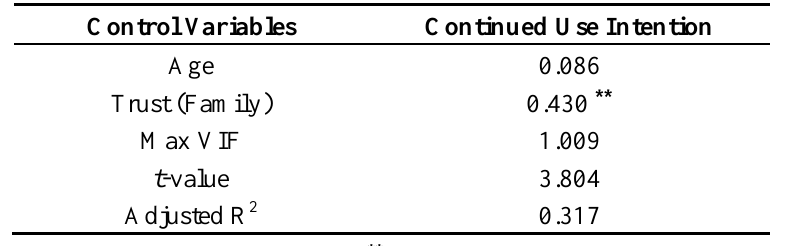
Table 4. Family trust and the intention to continue using